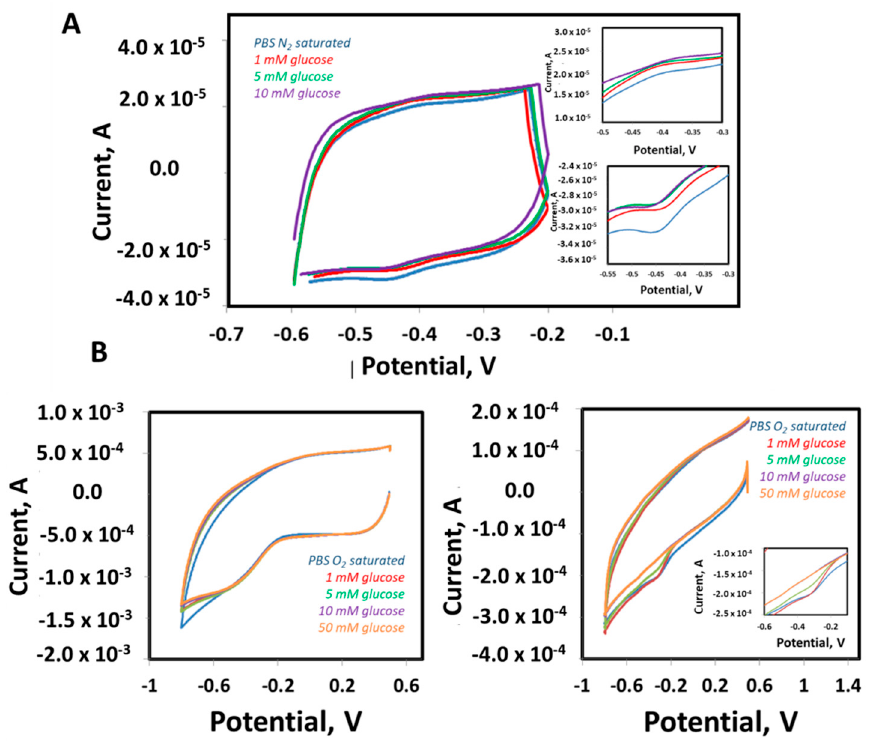
Figure 5. GOx-based bioanode enzyme activity evaluation. ( A ) Cyclic voltammperometry in PBS N2 saturated (blue) with different glucose concentrations: 1 mM (red), 5 mM (green), 10 mM (purple). Scan rate 4 mV s − 1 . ( B ) Cyclic voltammetry in PBS O 2 saturated (blue) with different glucose concentrations: 1 mM (red), 5 mM (green), 10 mM (purple), 50 mM (orange). CH-CB electrode in the absence of GOx (left), CH-CB modified with GOx (right). Insets: magnification of reduction and oxidation peaks. Scan rate 75 mV s − 1 .